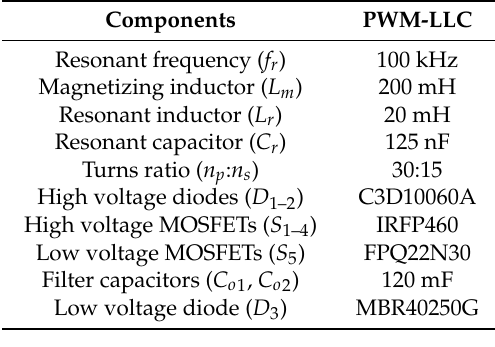
Table 2. Design Parameters of the Prototypes.